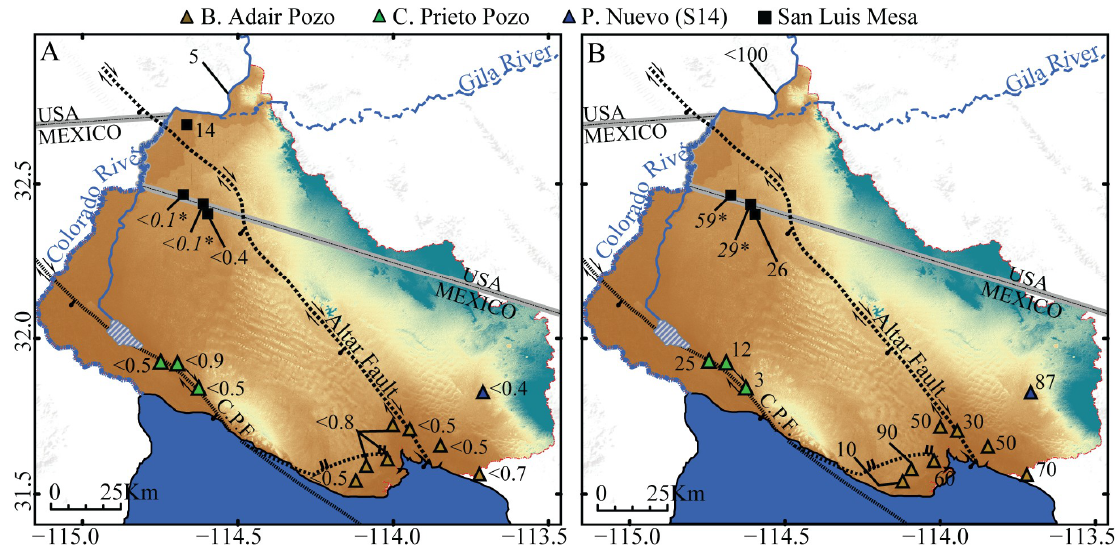
Figure 8. ( A ) Tritium (TU) data for water samples in the study area. ( B ) Carbon-14 (pMC) for water samples in the study area. Data shown with asterisk (*) from [24].